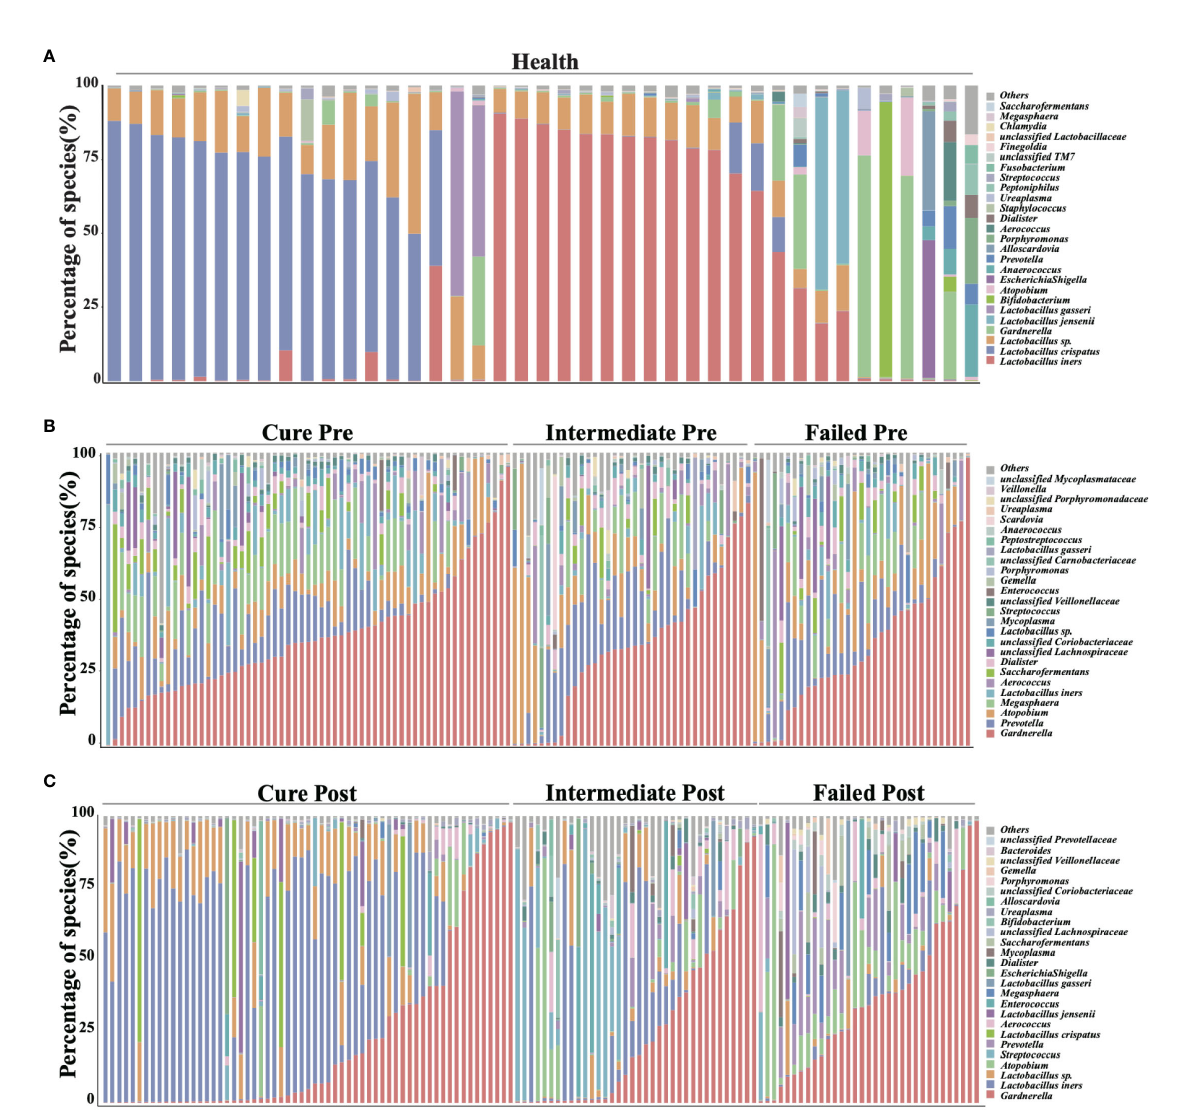
FIGURE 1 Vaginal microbiome composition of studied cohort. This fi gure manifests the top 26 most abundant bacteria in participants ’ vaginal microbiome, organisms ranked 27 and below are all categorized into label “ others ” . (A) shows the vaginal microbiome of healthy participants, with (B) showing BV patients pretreatment and (C) showing